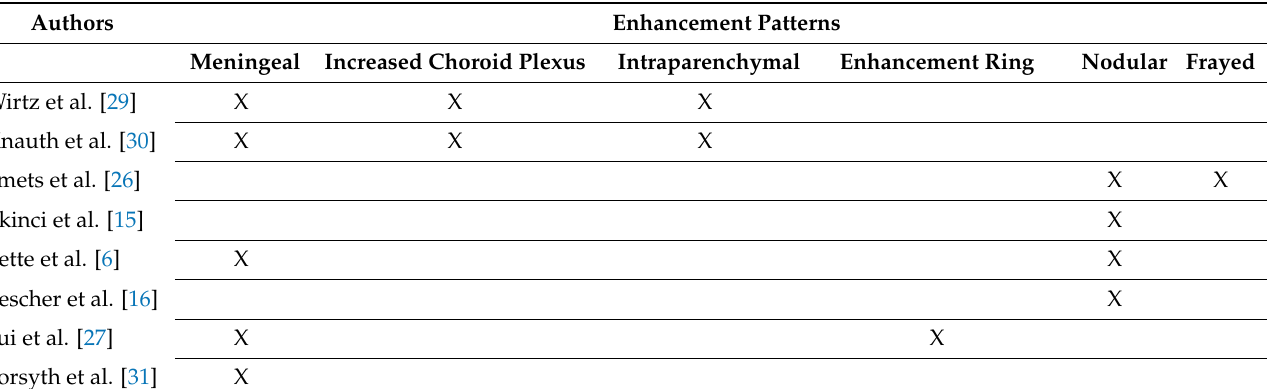
Table A2. Other patterns of contrast